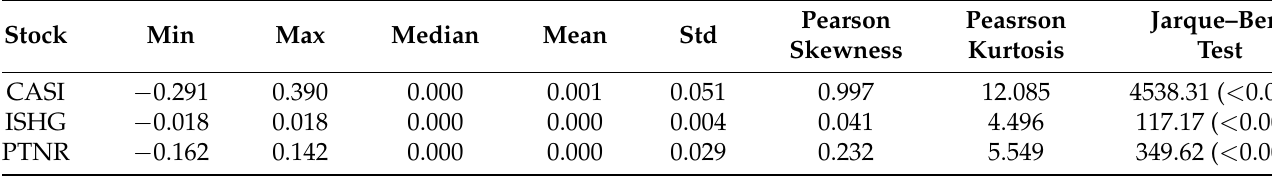
Table 1. Summary statistics for log-returns